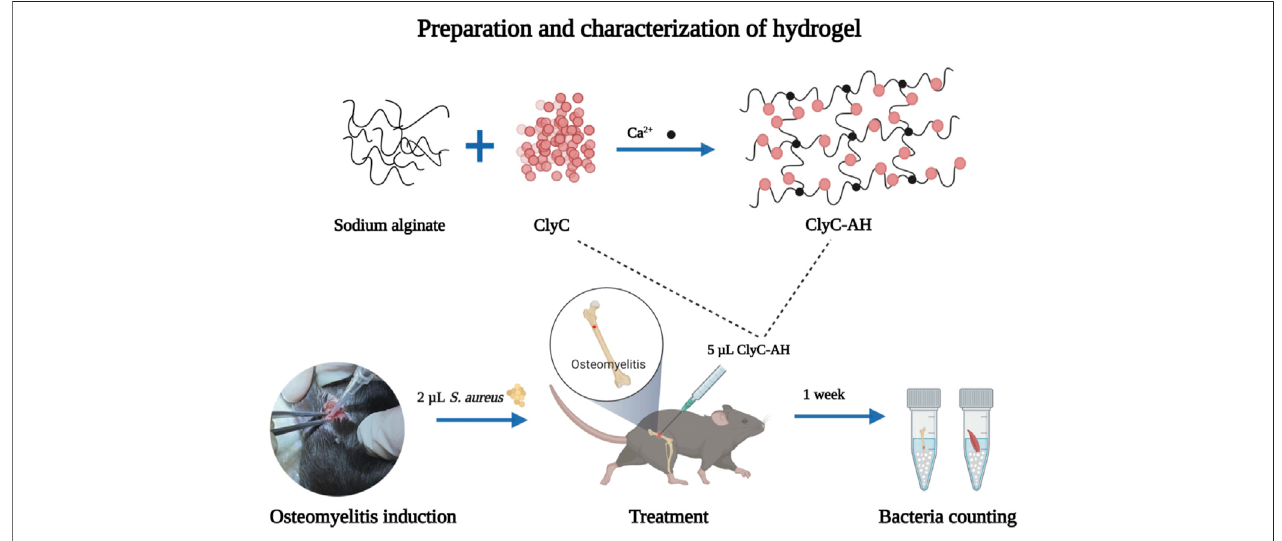
FIGURE 1 | The overall experiment design of the study. 2 µL S. aureus was injected into the marrow cavity for creating an osteomyelitis model. A hydrogel loaded with ClyC was synthesized. ClyC would target and cleave the cell wall conserved domain, leading to lysis. ClyC resulted in infection reduction.